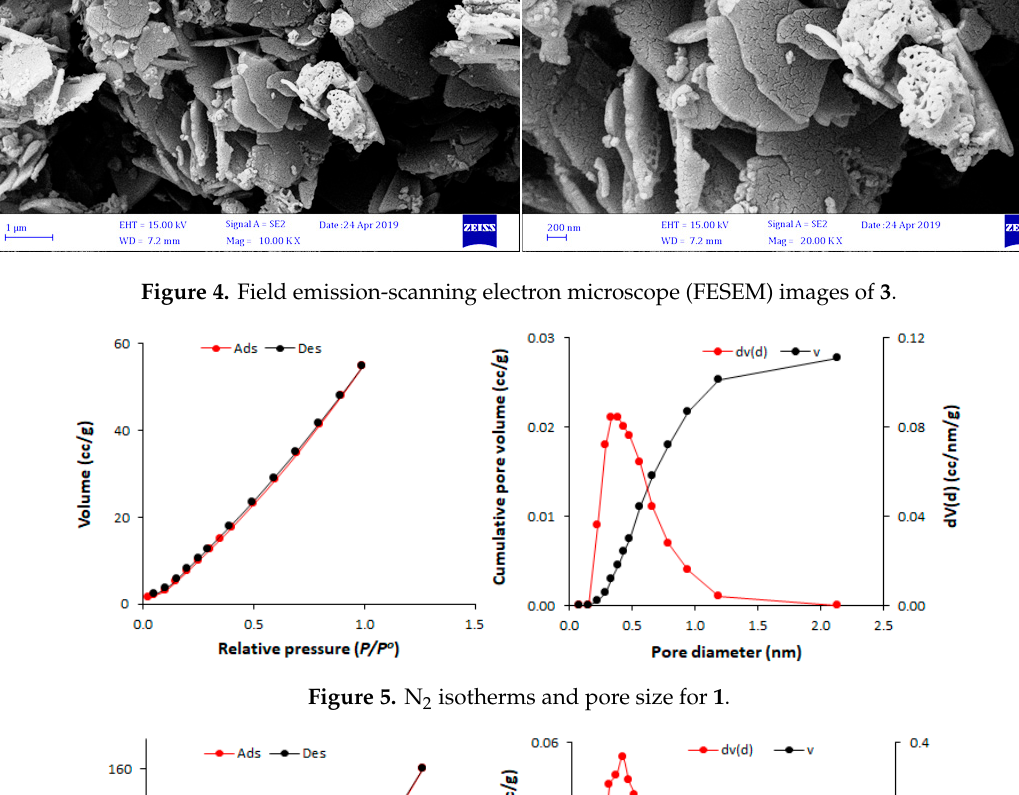
Table 3. Porosity properties of 1–3 .